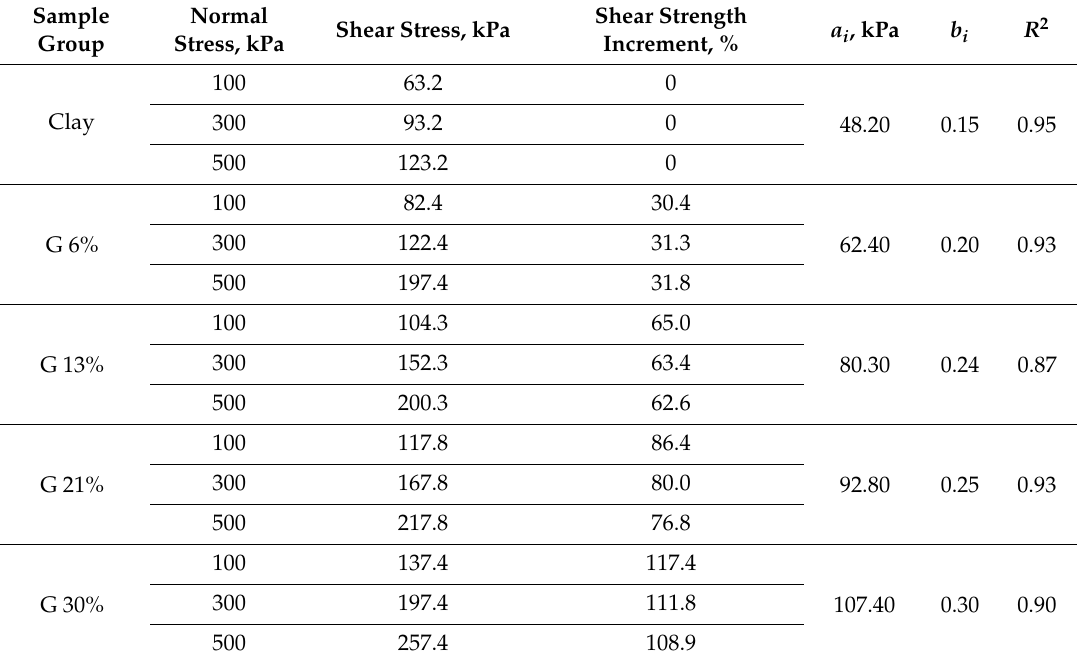
Table 5. The results of the direct shear test of the clay